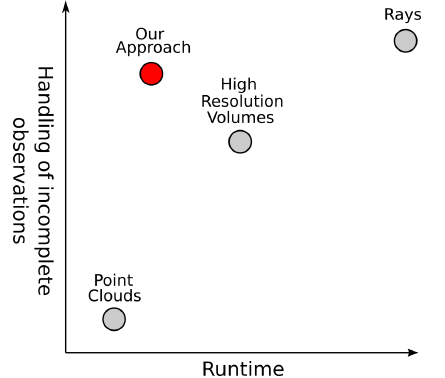
Figure 1. Our approch in context of change detection